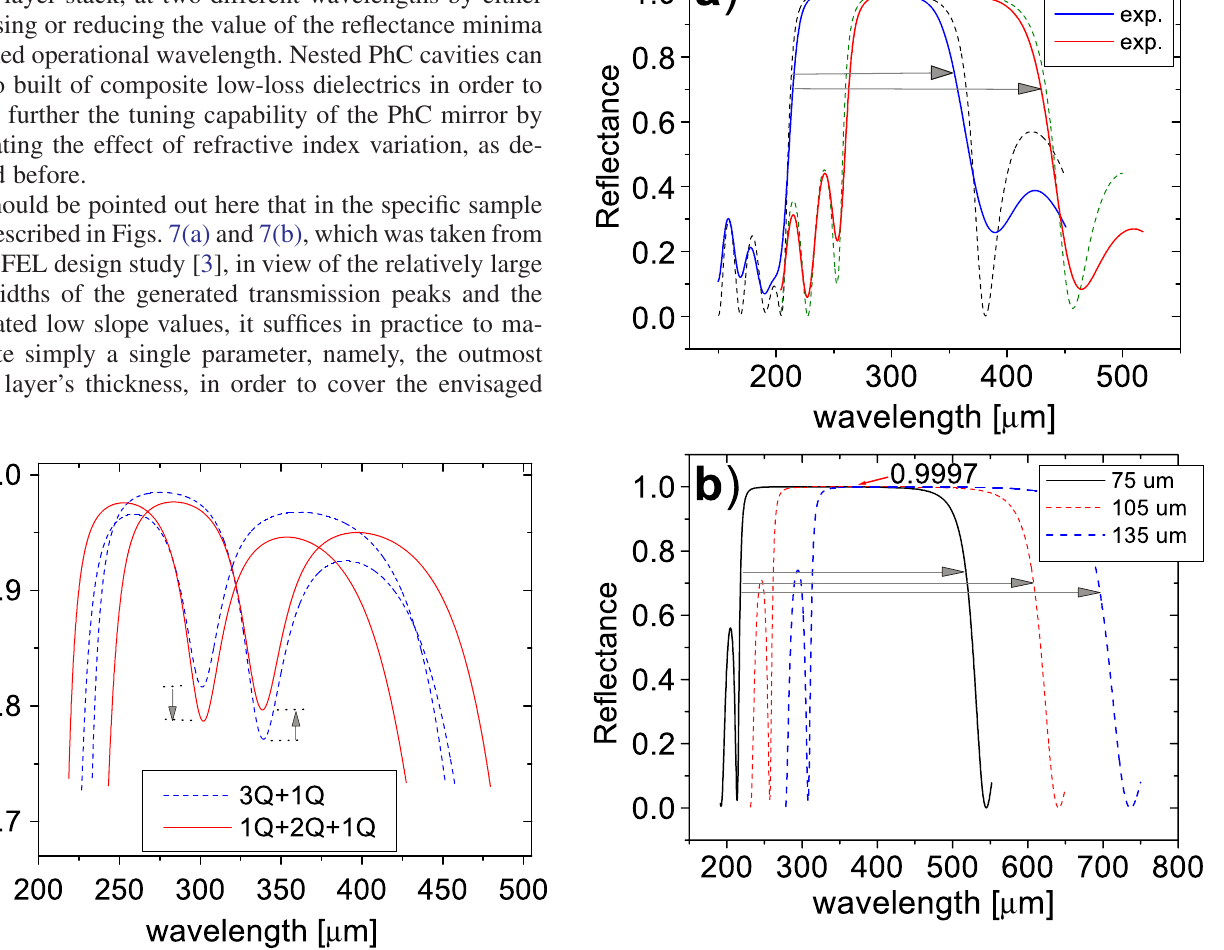
FIG. 9. (Color) Dashed curves represent the reflectivity minimas generated by the 3 þ 1 configuration. Note that the latter con- trols only position of the reflectivity dip but not its amplitude. This task can be accomplished by using the nested PhC cavity.